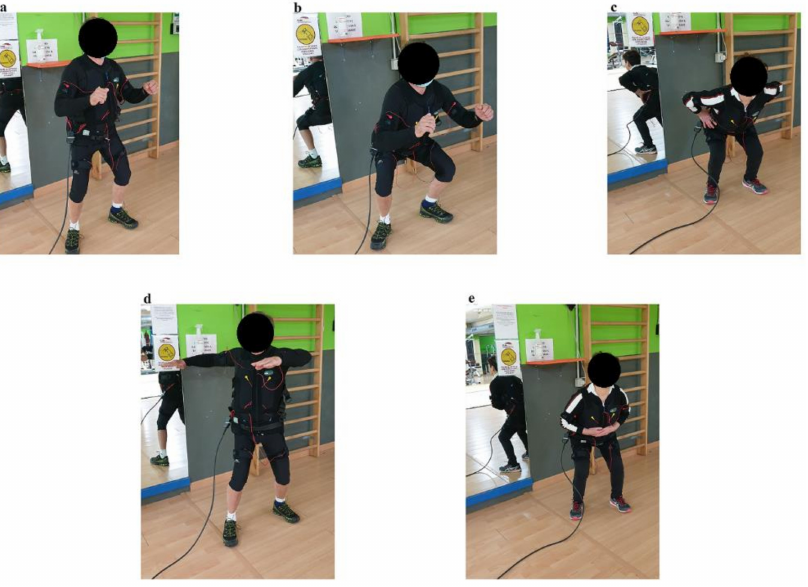
Figure 2. Workout session. ( a ) Half squat; ( b ) full squat; ( c ) bent over; ( d ) core rotation; ( e ) crunch. In the WB-EMS intervention, the 20-min workout session combined the 5 voluntary strength exercises to a superimposed and supervised WB-EMS application, using the pro- tocol (rectangular stimulation at 75–85 Hz, 350 µ s, 4 s stimulation/4 s rest)